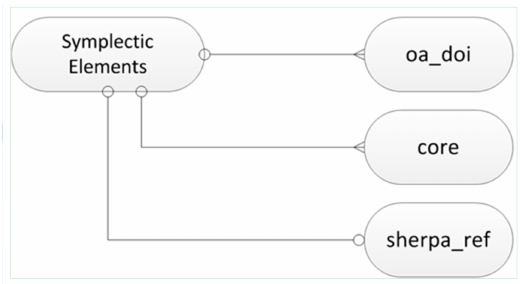
Figure 1. The conceptual data model, showing all entities and relationships used in the data analysis.